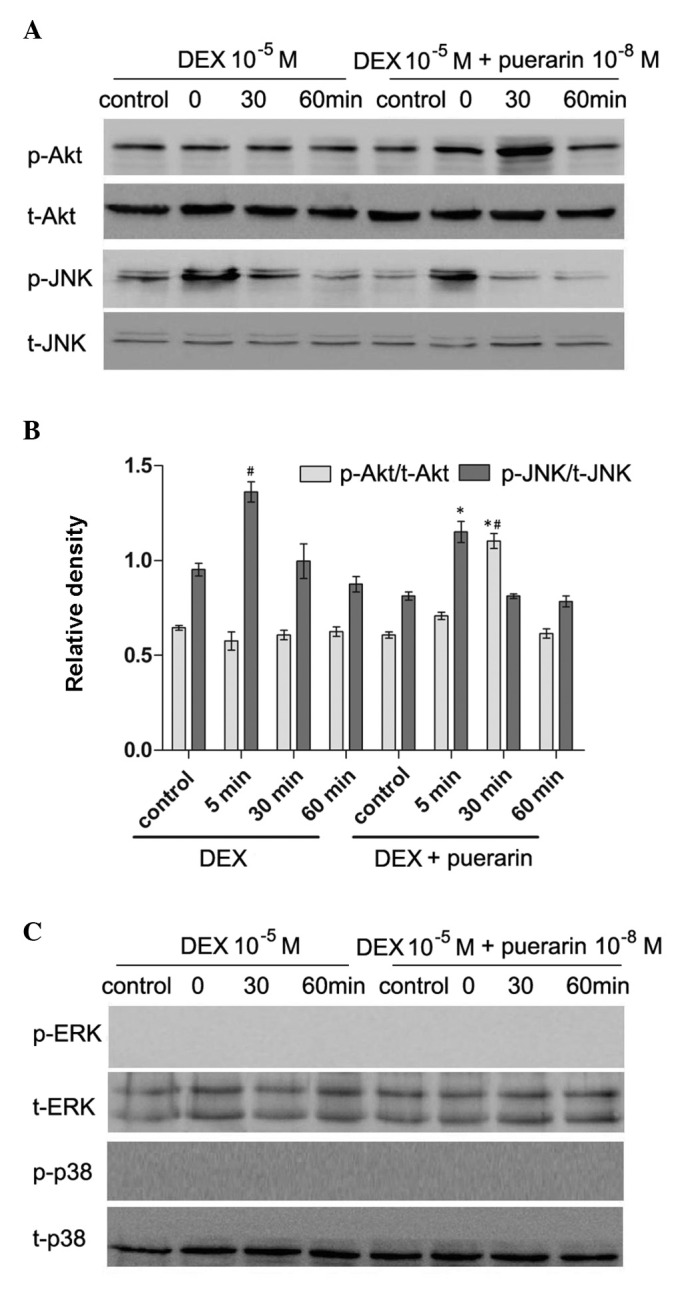
Effects of puerarin on the phosphorylation of JNK and Akt in hFOB1.19 cells. (A and C) Cells were treated with DEX (10−5 M) alone or in combination with puerarin (10−8 M) for 5, 30 and 60 min. Western blot analysis was performed to detect the expression levels of p-JNK, JNK, p-Akt, Akt, p-ERK and ERK. (B) Relative expression levels of p-Akt and p-JNK compared with t-Akt and t-JNK were analyzed, respectively. Data are presented as the mean ± standard deviation (n=3). *P<0.05, vs. DEX; #P<0.05, vs. control. JNK, c-Jun N-terminal kinase; ERK, extracellular signal-regulated kinase; p-, phosphorylated; t-, total.